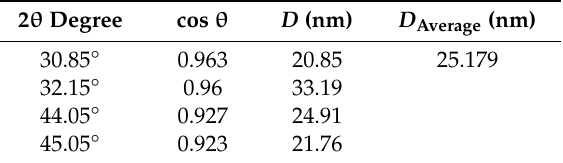
Figure 2. X-ray diffraction pattern for SnTiO3 nanoparticles (NPs). Figure 2. X-ray di ff raction pattern for SnTiO3 nanoparticles (NPs). Table 1. Nanoparticle size D determination using Debye-Scherrer’s equation. 2 θ Degree